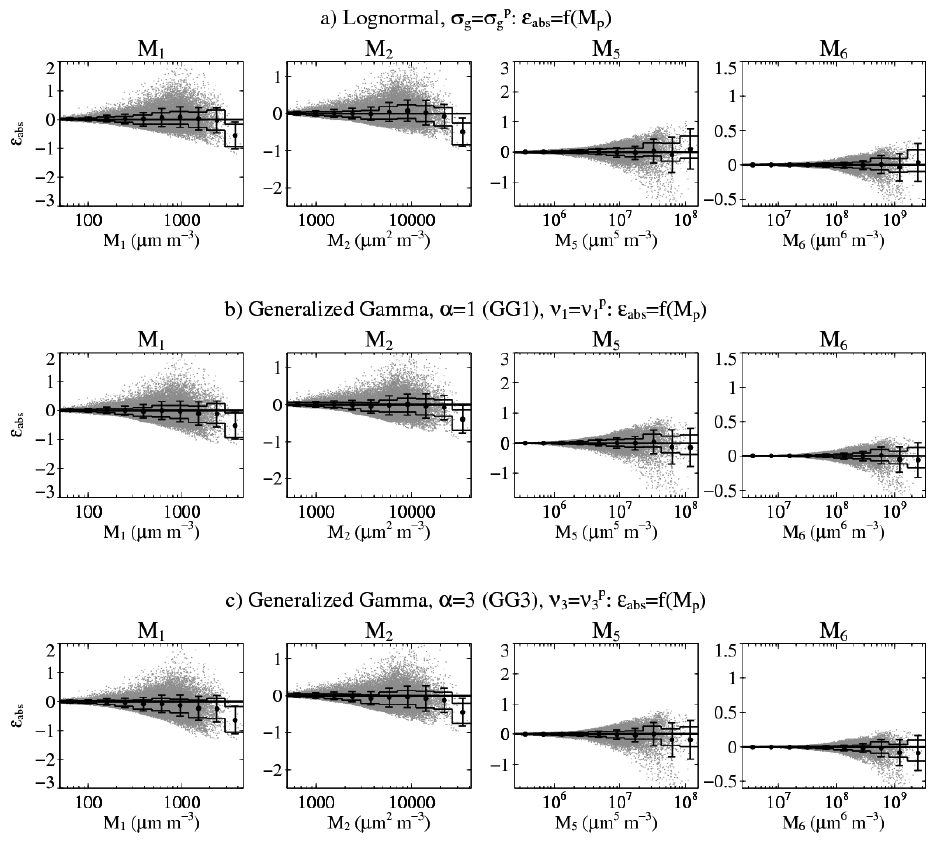
Fig. 6. Same as Fig. 3 using the proposed parameterization for the variable tuning parameter.